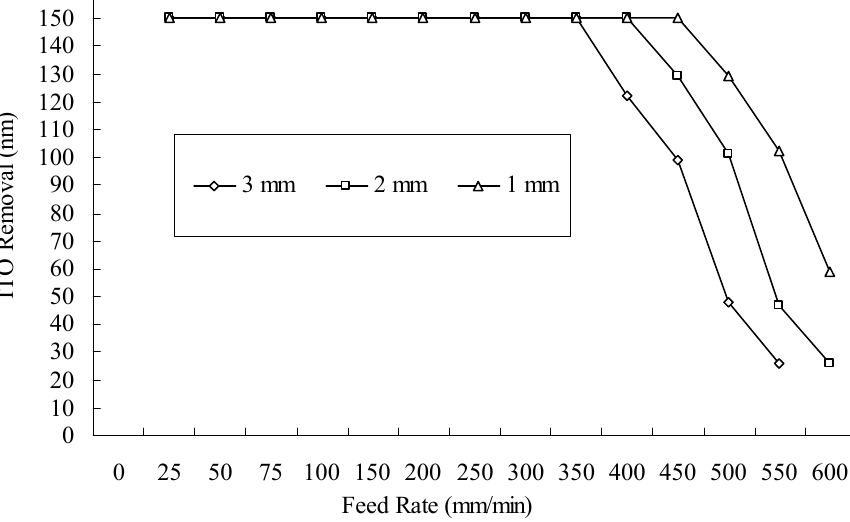
Figure 4. Amount removed at different feed rates and different eccentricities of the negative-electrode (NaNO of 10 wt% and PO4-3-P 5 wt%, 55 °C, 25 L/min, 100 A, 3 continuous DC, negative-electrode 300 rpm).